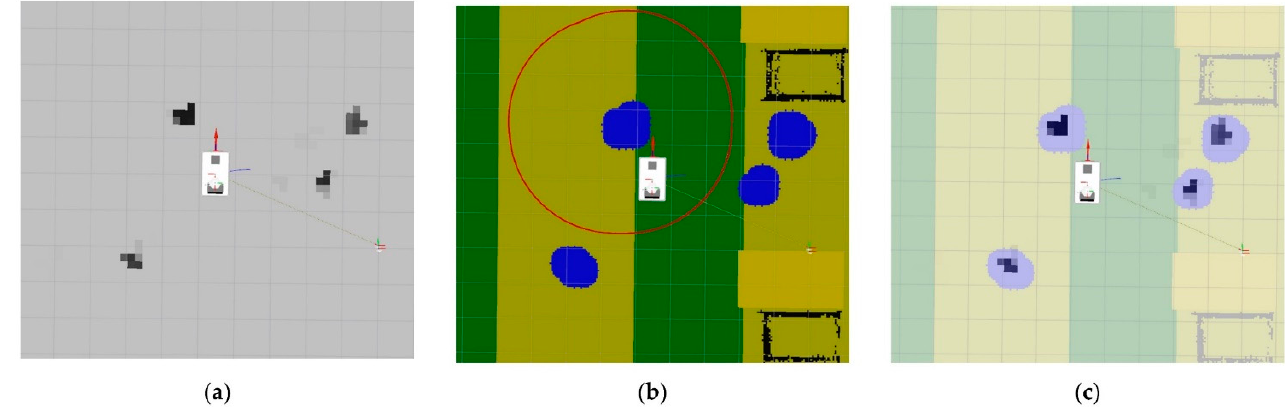
Figure 4. Human layer. ( a ) Occupancy grid map provided by the WMS; ( b ) costmap M with buffer zones around the human cells in blue and one exemplary visualized human safety zone (red circle); ( c ) costmap and occupancy grid map overlayed.